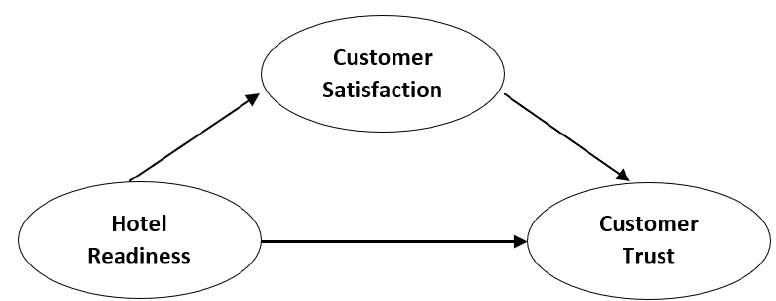
Figure 1: Research